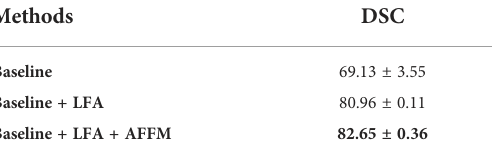
The bold values indicate the best results achieved by the corresponding